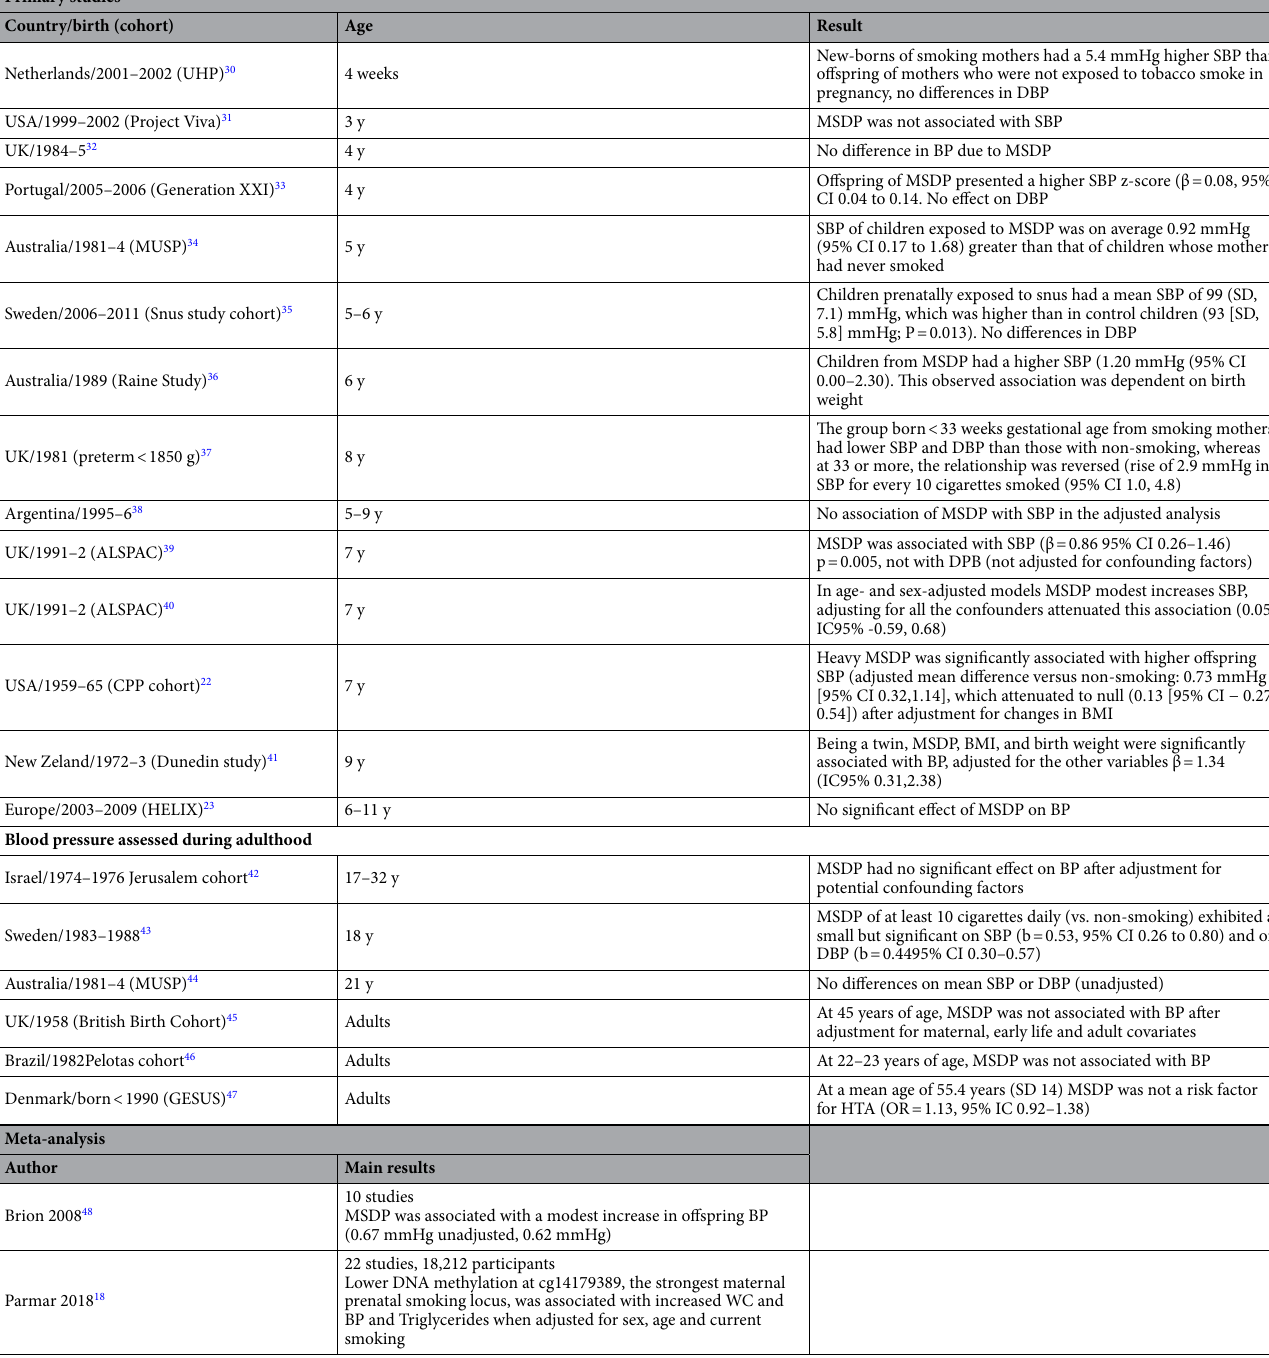
Table 5. Summary of studies on the effect of maternal smoking during pregnancy on offspring blood